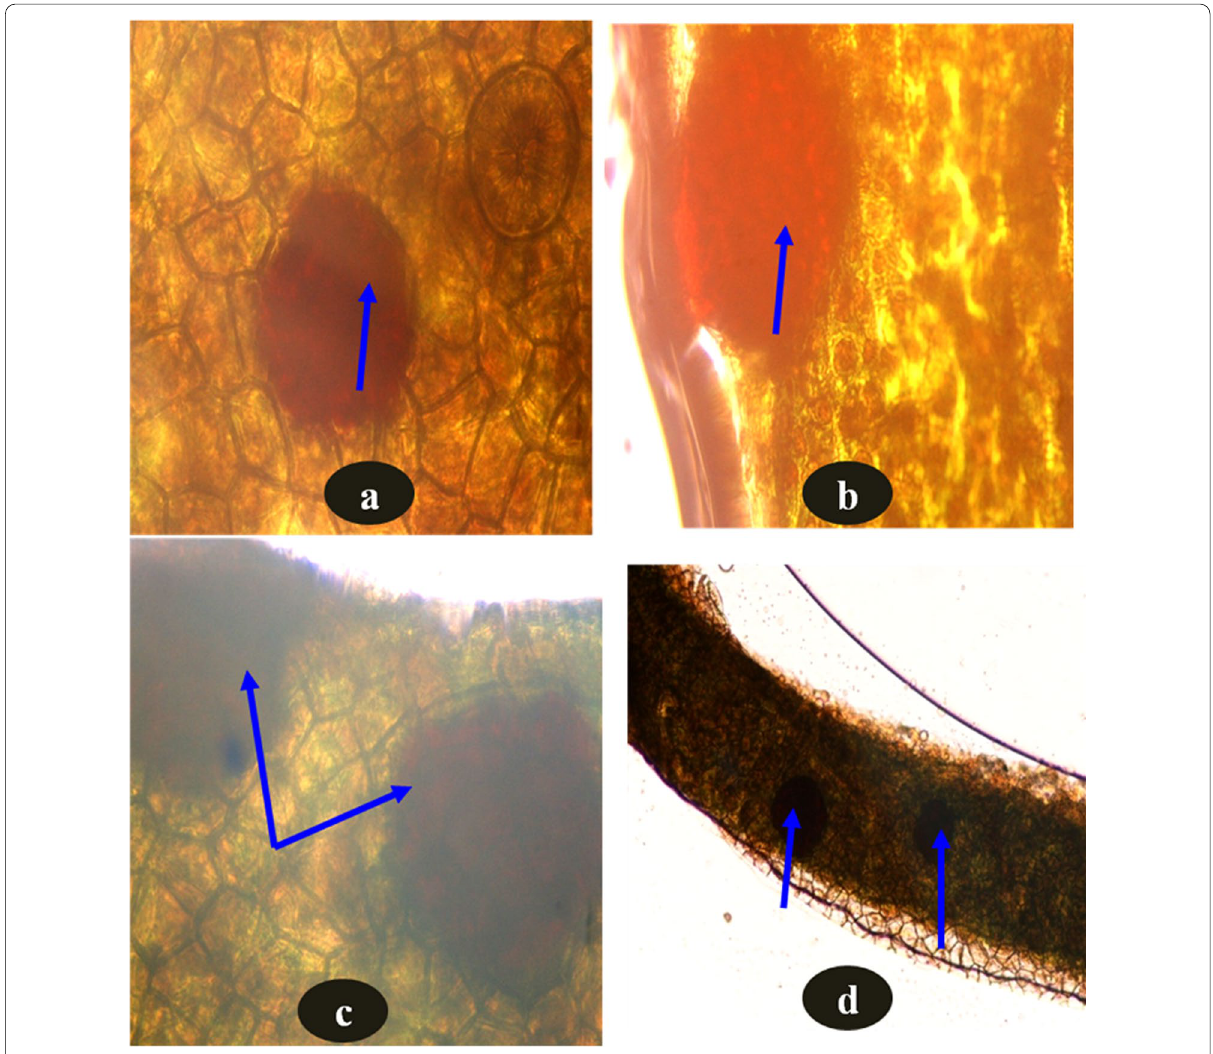
Fig. 4 TS of leaf samples of A. corniculatum showing localization of embelin in a mesophyll cells, b below the epidermal layer (arrowhead), c presence of two-embelin deposition near epidermal layer (arrowhead) (All three in 40 (arrowhead)